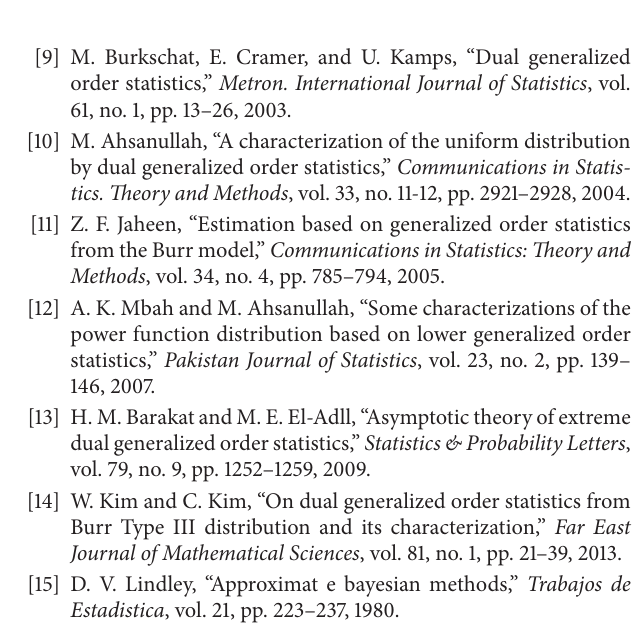
Table 1: The averaged RMSE for MLE and Bayes Estimates of the parameters 𝑘 and 𝑐 for different 𝑛 . 𝑛 ̂𝑐